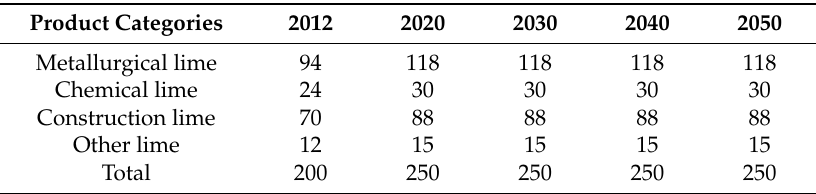
Table 2. Lime production under the BAU scenario